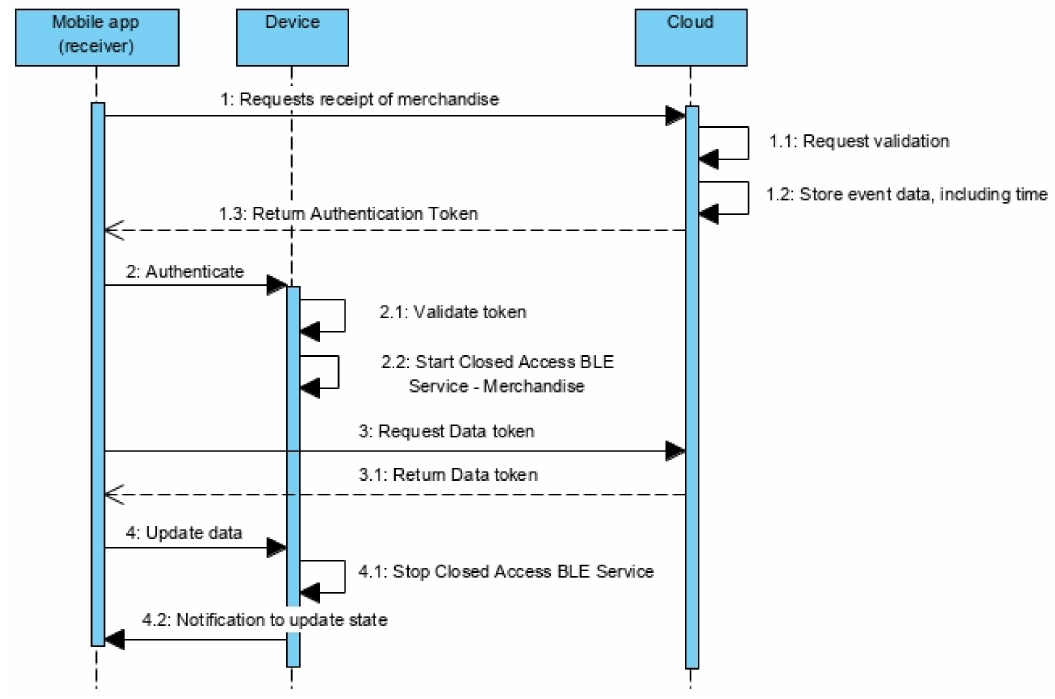
Figure 8. Merchandise receipt